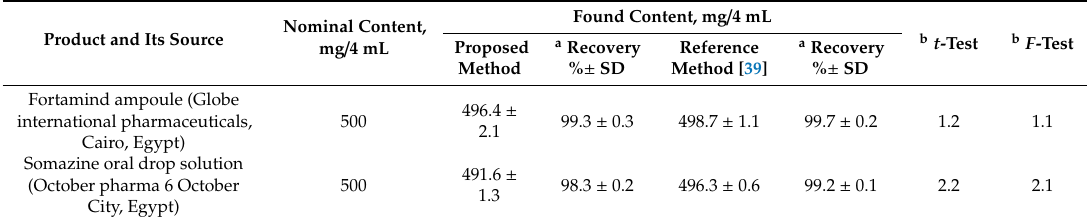
Table3. Assessmentofciticolineindi ff erentpharmaceuticalformulationsusingthepresentedelectrodes. Product and Its